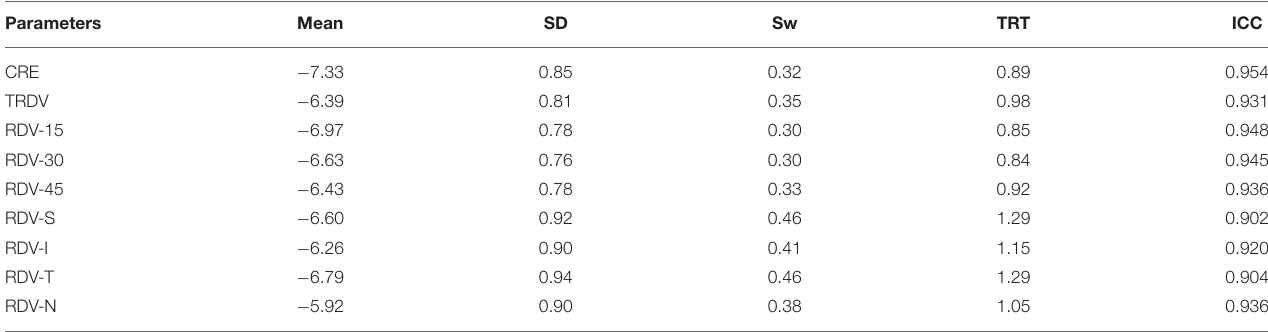
TABLE 6 | Intraobserver repeatability outcomes of central and peripheral refraction using MRT with cycloplegia of low myopia group. Parameters Mean SD Sw − 2.46 − 2.03 RDV-45 − 1.44 RDV-S − 1.68 RDV-T − 1.65